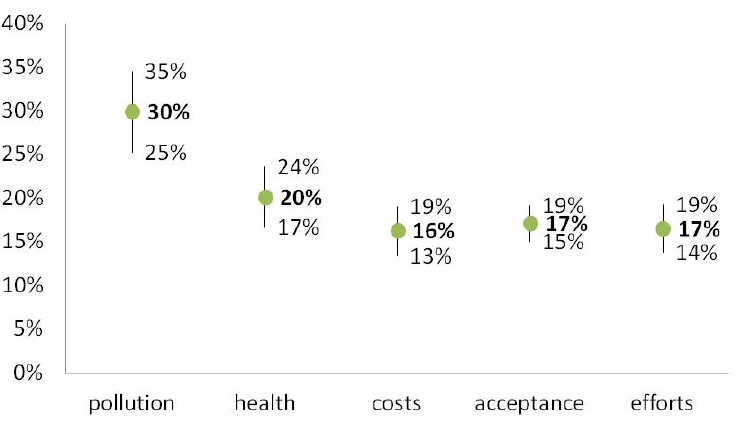
Figure 2. Confidence intervals for AHP criteria weights: Mean values (boldface) and upper and lower 95%-confidence limits (based on the normal distribution) for the mean values of AHP criteria